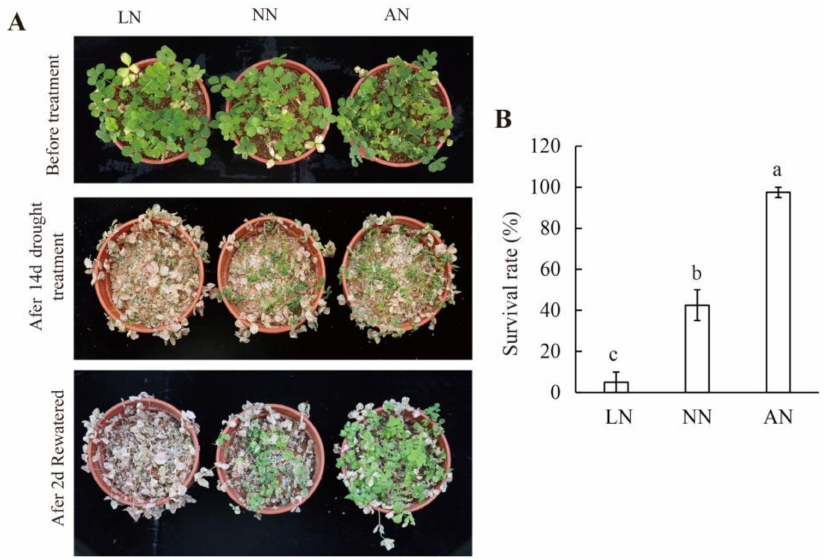
Figure 3. Plant performance in Chinese milk vetch as affected by rhizobia inoculation and drought stress. Ninety-day-old plants were exposed to 14 days of withholding irrigation, followed by 2 days of rewatering. Photographs were taken at the times indicated in figure ( A ), while the survival rate was recorded after 2 days of rewatering ( B ). AN, LN, and NN indicate the plants with active nodules, low-activity nodules, and no nodules, respectively. The data presented are means and standard errors of three replicates, and the same letter above the column indicates no significant difference at p <